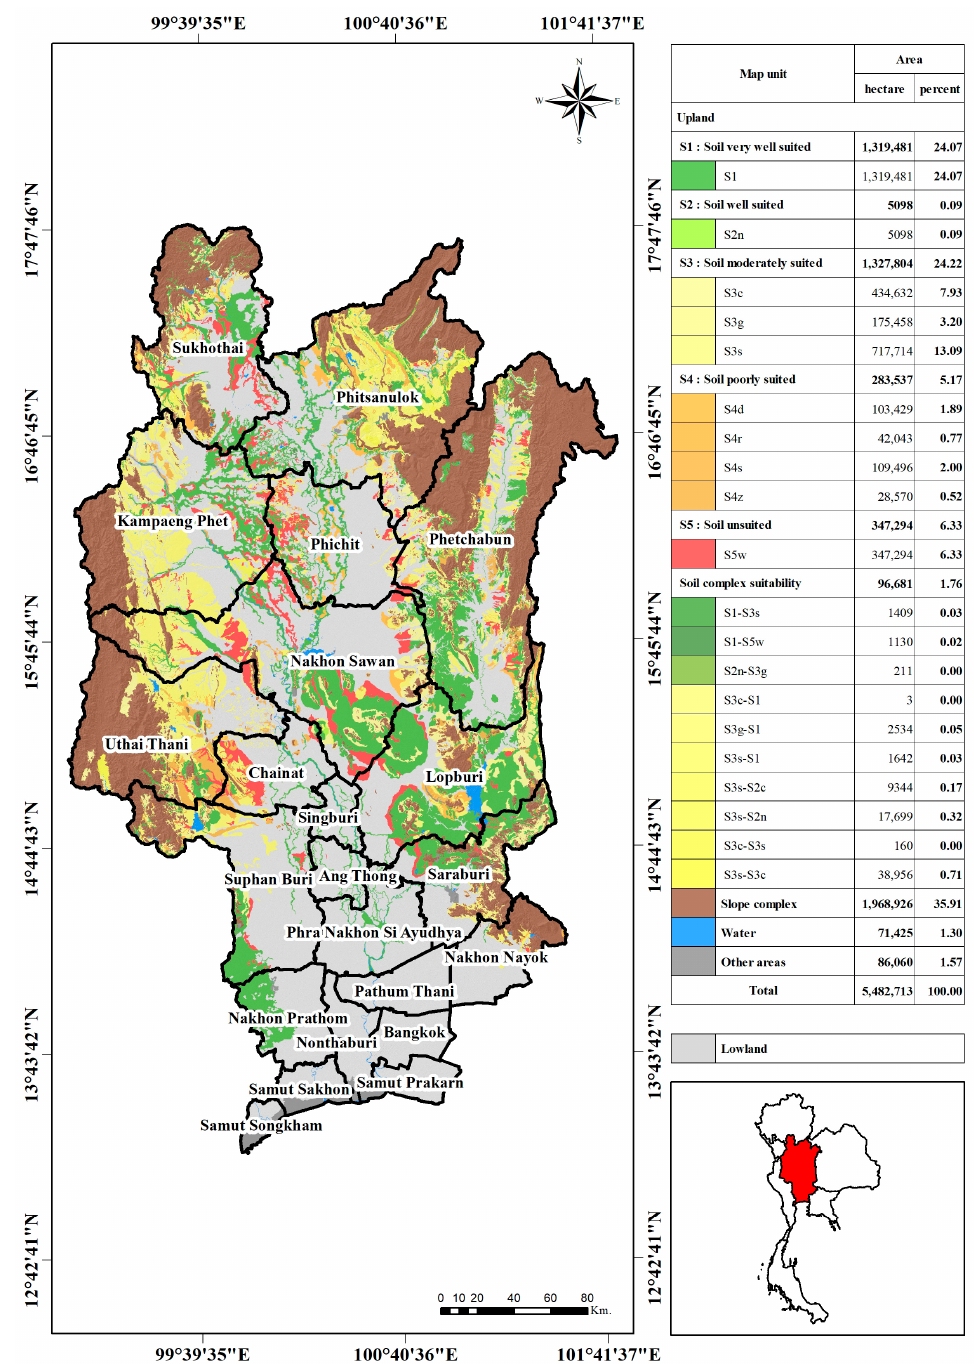
Figure 2. Suitability assessment of upland soil for mung bean cultivation in central Thailand. The areas that were poorly suitable for mung bean cultivation (S4) are shown on the map, using 4 color shades from orange to brown (Figure 2). S4 accounted for 283,537 ha (Table 3). In this suitability classification, the constraint factors were soil drainage (d), rockiness (10–50% of the area; r), coarse textured soil (s), and stoniness (15–50% of the area; z). The areas that were characterized as S4 were in Nakhon Sawan, Uthai Thani, Phetchabun, and Nakhon Nayok provinces. The areas that were classified as unsuitable for mung bean plantation (S5) are exhibited on the map in red, making up 347,294 ha (Figure 2 and Table 3). Water logging (w) was the main constraint factor for this classification. Areas classified